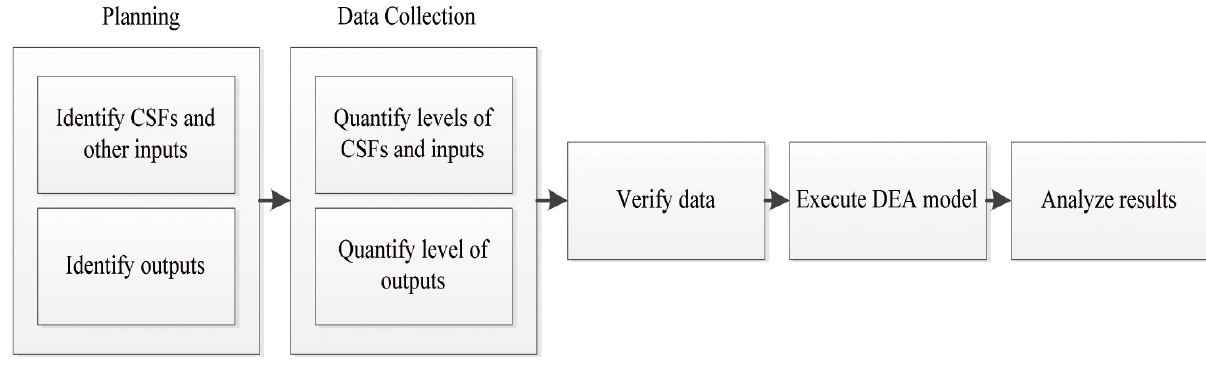
Figure 1. Overall